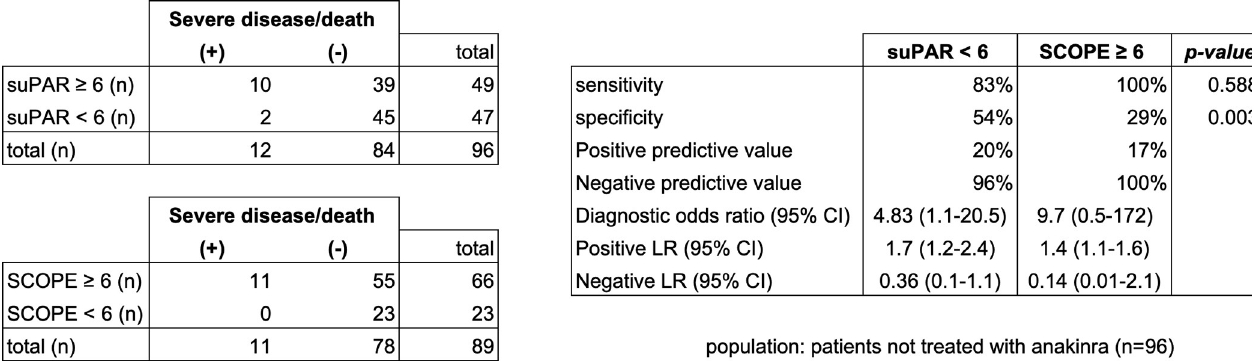
Fig 3. suPAR vs SCOPE score performances in predicting progression to severe disease or death at day 14. Severe disease is defined according to the WHO Clinical Progression Scale (WHO-CPS score 6–10). CI = Confidence Interval; LR = likelihood ratio.